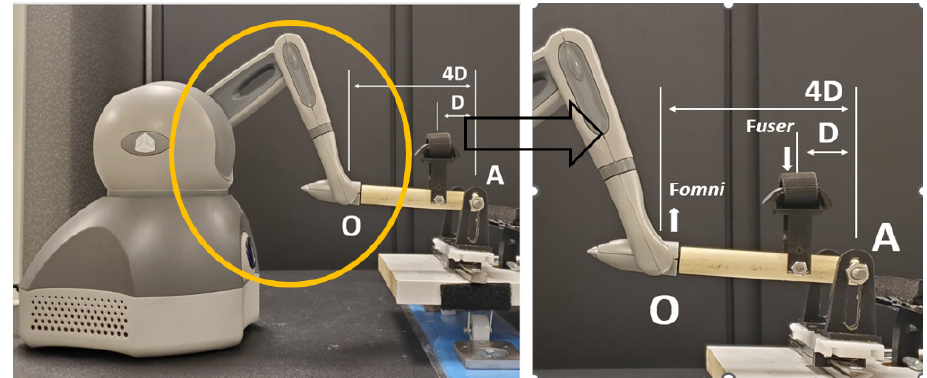
Figure 3. Geomagic Touch TM haptic device with modified stylus. The modified stylus can rotate about the link at point A and slide on the linear guide rail sideways (in and out of the page as shown). The finger holder with a strap allows palpation with only one finger. Point O is the original pivot (the distal end of the second arm) of the haptic device and D = 28 mm).